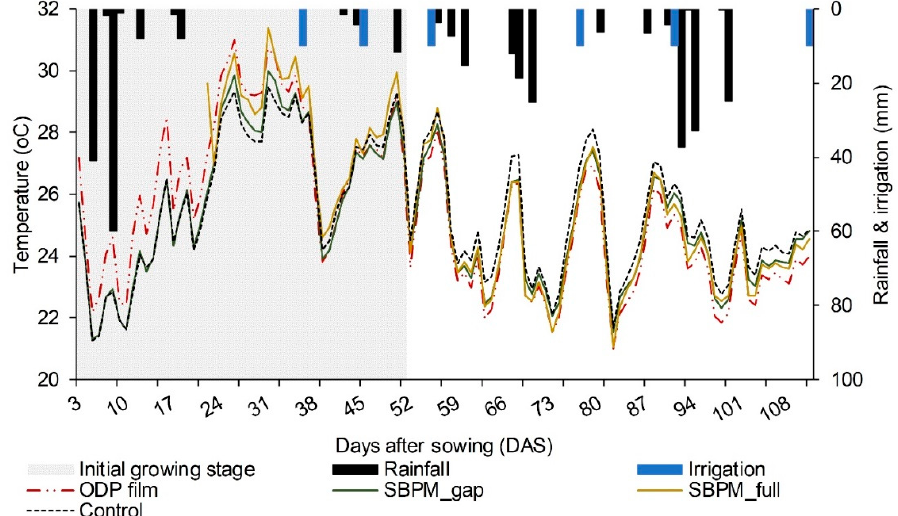
Figure 2. The e ff ects of oxo-degradable plastic (ODP) mulch film and sprayable biodegradable polymer Figure 2. The effects of oxo-degradable plastic (ODP) mulch film and sprayable biodegradable membrane (SBPM_gap and SBPM_full) treatments on soil temperature ( ◦ C) measured at 10 cm soil polymer membrane (SBPM_gap and SBPM_full) treatments on soil temperature (°C) measured at 10 depth, during 2015 / 16 at the ACRI field site ( n = 10 plots; SBPM_full not cm soil depth, during 2015/16 at the ACRI field site ( n = 10 plots; SBPM_full not replicated).